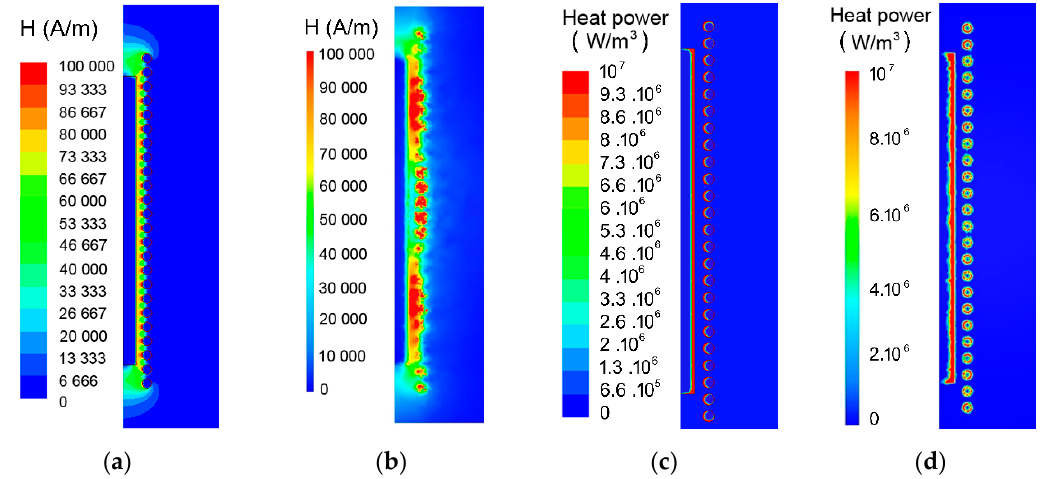
Figure 4. Magnetic field intensity distribution in the 2D model ( a ) and the 3D model ( b ); heat power (Joule heat) distribution in the 2D model ( c ) and the 3D model ( d ).